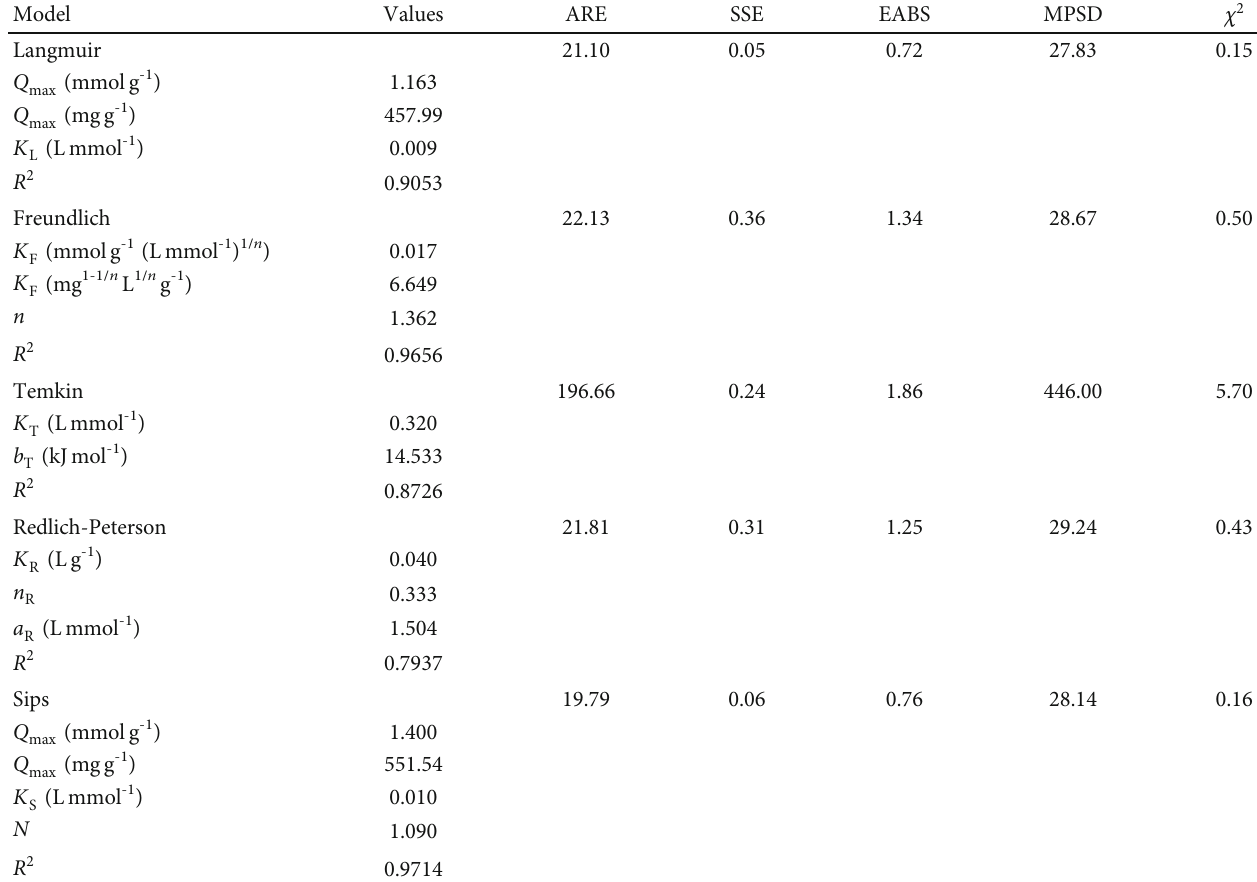
Table 2: Adsorption isotherm models and their